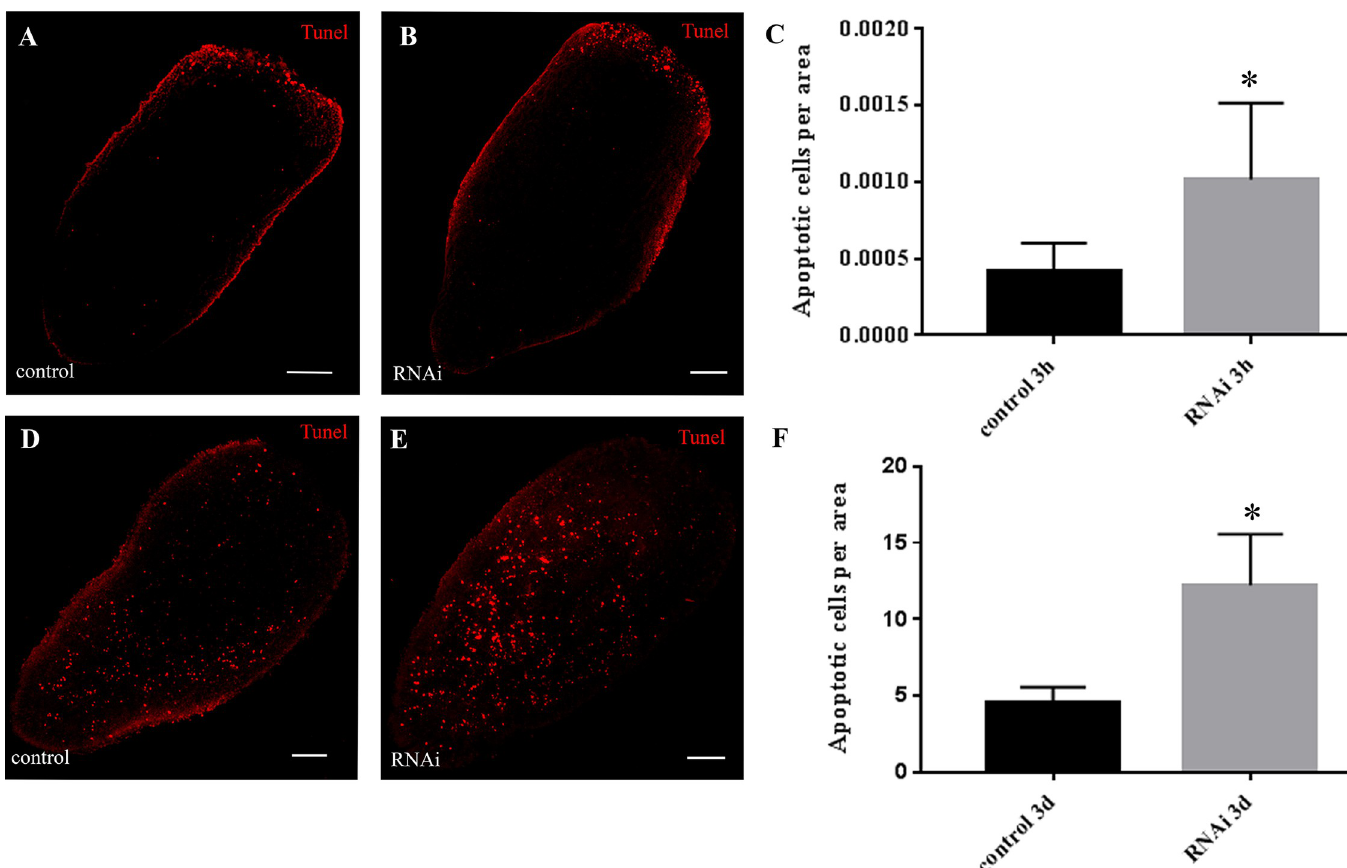
Fig 5. Analysis of apoptosis, by TUNEL assay, in DjMap1B silenced animals. In A, B, C data were collected 3 hours after cutting, a time at which apoptotic cells (red dots) are accumulated below the wound epithelium. (A) A representative confocal image of a regenerating control tail fragment. (B) A representative confocal image of a regenerating RNAi tail fragment. (C) Graph depicting the quantification of the number of apoptotic cells. In D, E, F data were collected 3 days after cutting, a time at which apoptotic cells are scattered throughout the parenchyma. (D) A representative confocal image of a regenerating control tail fragment showing cells in apoptosis (red dots). (E) A representative confocal image of a regenerating RNAi tail fragment. (F) Graph depicting the quantification of the number of apoptotic cells. Each bar (C and F) is the mean ± standard deviation of 5 independent samples of a representative experiment. h (hours); d (days). � p < 0.05. Scale bar is 100 μ m in A-D.